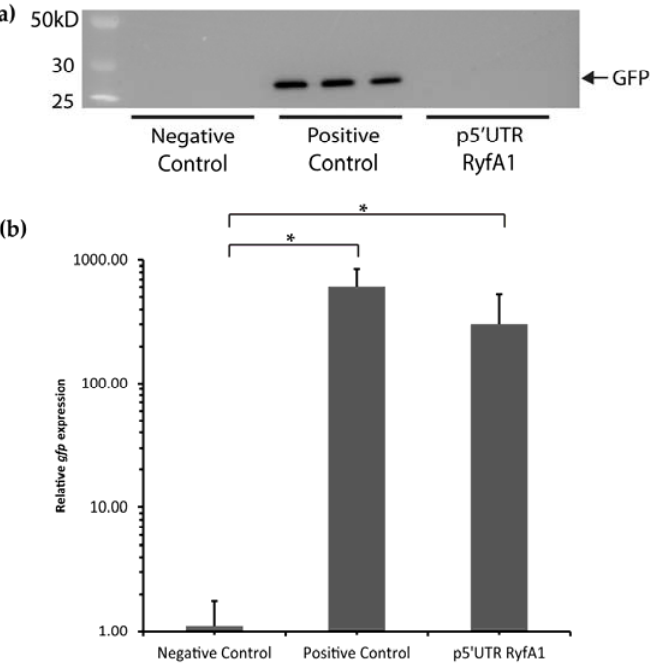
Figure 9. Sequences within the ryfA1 transcript do not mediate translation initiation. ( a ) Western blot analysis was used to detect GFP production in E. coli carrying a negative control plasmid (pXG ‐ 0), the experimental plasmid p5 ′ UTR RyfA1, or a positive control plasmid (pXG ‐ 1). Under the conditions tested, no GFP was produced in the strain carrying p5 ′ UTR RyfA1, indicating that the cloned sequences do not support translation initiation, and thus that the ryfA1 transcript likely does not encode a small peptide. ( b ) qRT ‐ PCR was used to ensure that the same triplicate samples used to detect GFP protein were producing gfp transcript. Strains carrying either the positive control or the p5 ′ UTR RyfA1 plasmid produce significantly more transcript than the negative control. Error bars represent one standard deviation. * indicates a significant difference ( p < 0.05). Relative levels were calculated using the ΔΔ Ct method [24] where gfp levels are normalized to the amount of rrsA present in each sample and are expressed relative to that present in a single pXG ‐ 10 sample.